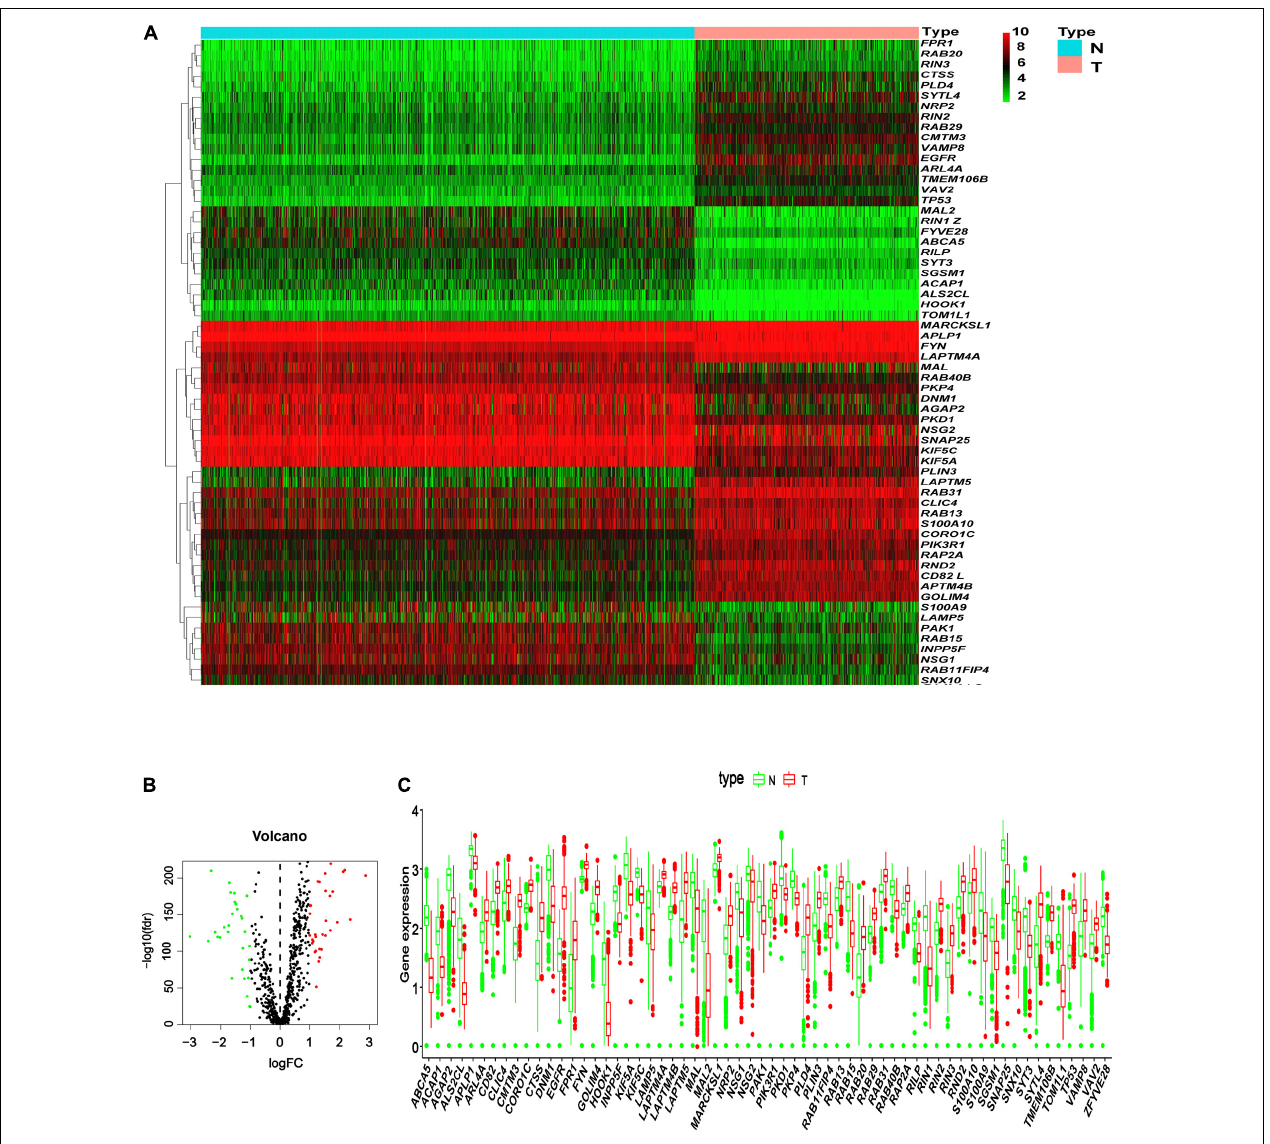
FIGURE 1 | Identification of differentially expressed endocytosis-related genes (DEERGs) between LGG and normal brain tissue. (A) 62 DEERGs were plotted in the heatmap. Columns represent the different samples, and rows represent genes. The gene marked with red color indicates upregulation, whereas the green color indicates downregulation. (B) The volcano plot of the differential expression of 676 endocytosis-related genes (ERGs) between LGG and normal brain tissue. The red and green colors showed highly expressed or low expressed genes, respectively. (C) The expression levels of 62 DEERGs were shown in the boxplot. N, normal brain tissue; T, LGG. The DEERGs were filtered with the threshold of |log 2 fold change (FC)| > 1 and FDR < 0.05.